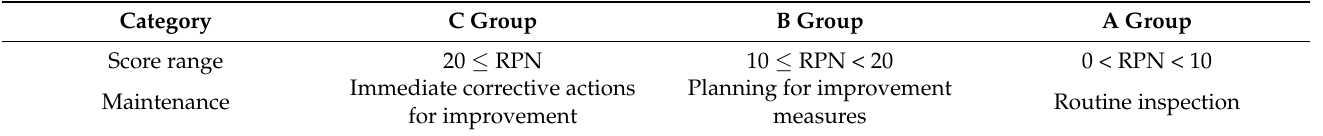
Table 8. Classification of RPN groups.